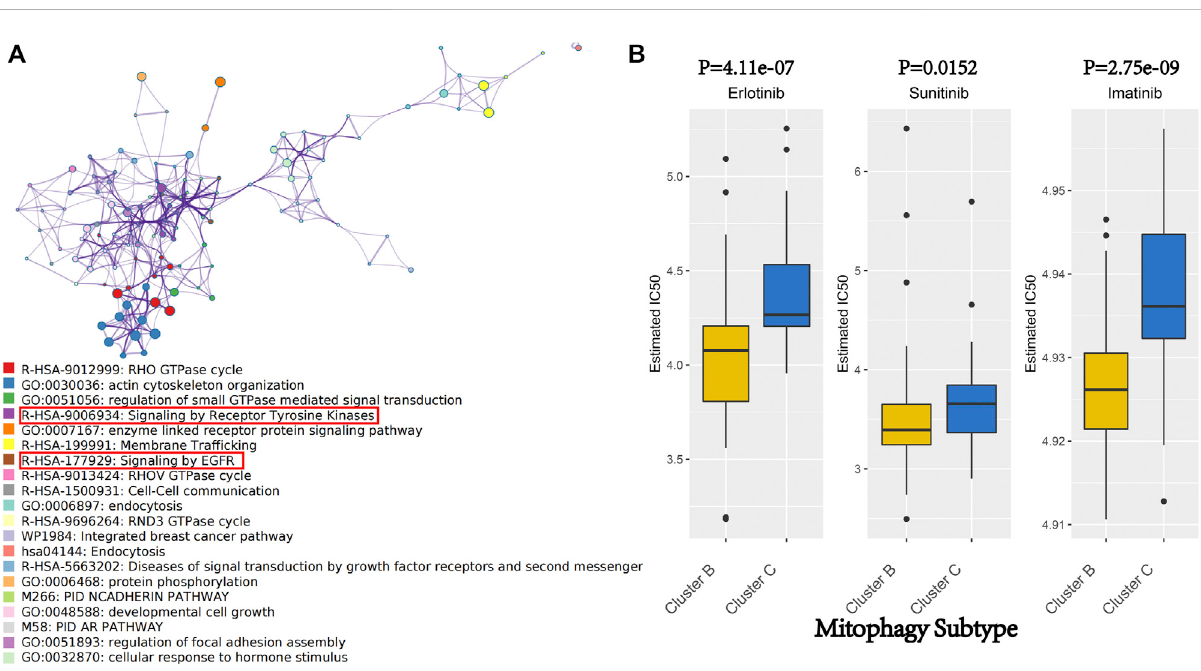
FIGURE 6 (A) Networkofenrichedtermsofhubgenesofgery60modulebyMetascape.ColoredbyclusterID,wherenodesthatsharethesameclusterID are typically close to each other. (B) We evaluated the IC 50 of Erlotinib, Sunitinib and Imatinib, between cluster B and cluster C by performing the R package “ pRRophetic.